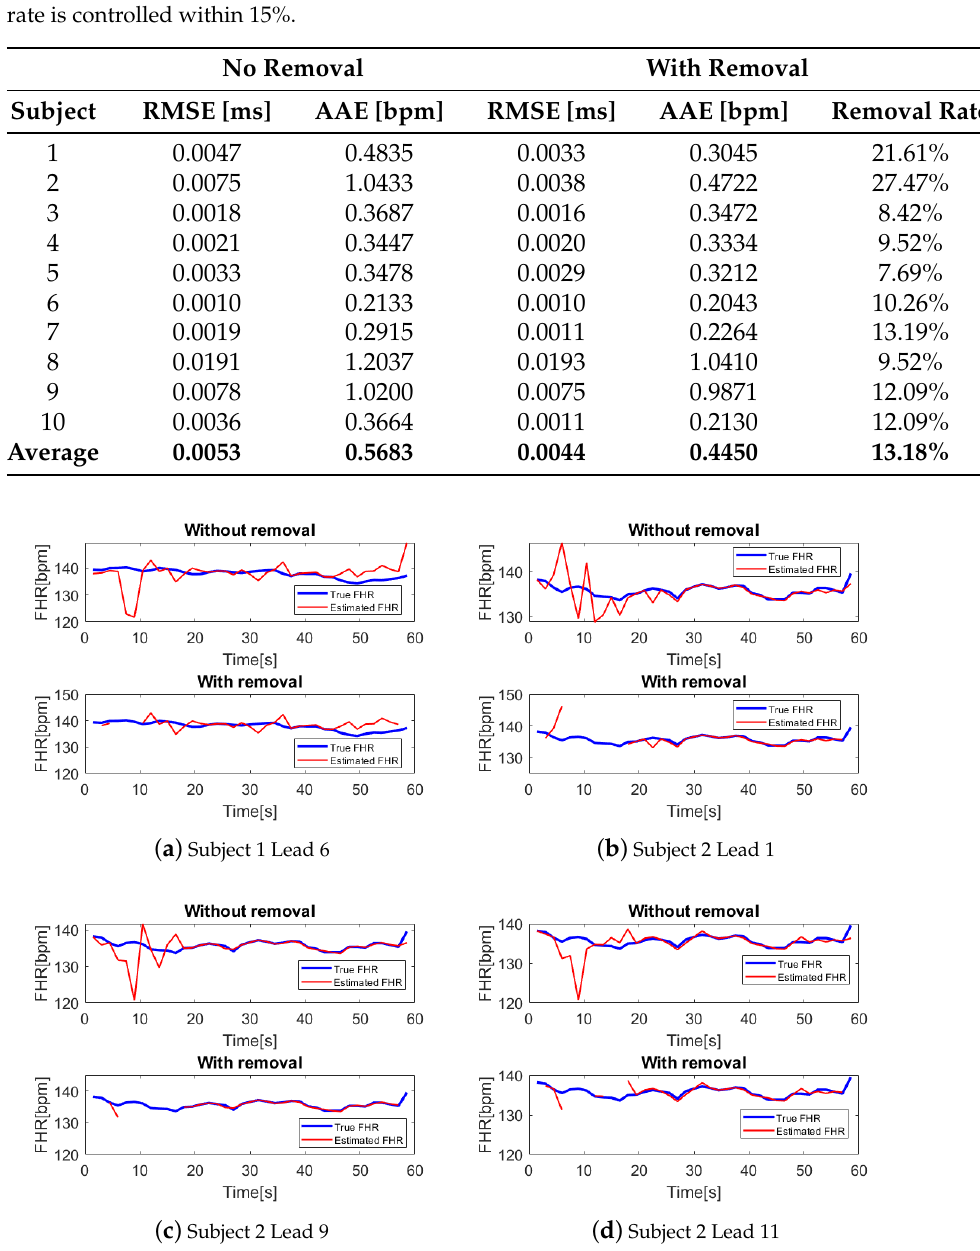
Figure 8. Examples of FHR estimation results with and without removal. It is obvious that the estimated FHRs with large errors are correctly removed by our proposed